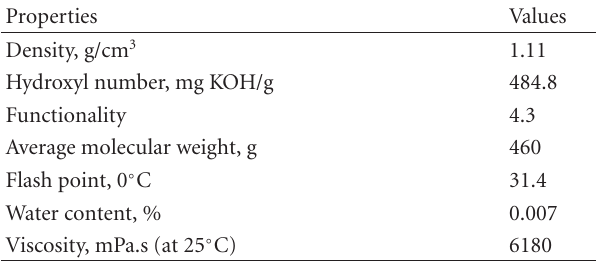
Table 2: Specifications of VORANOL 490 [30].